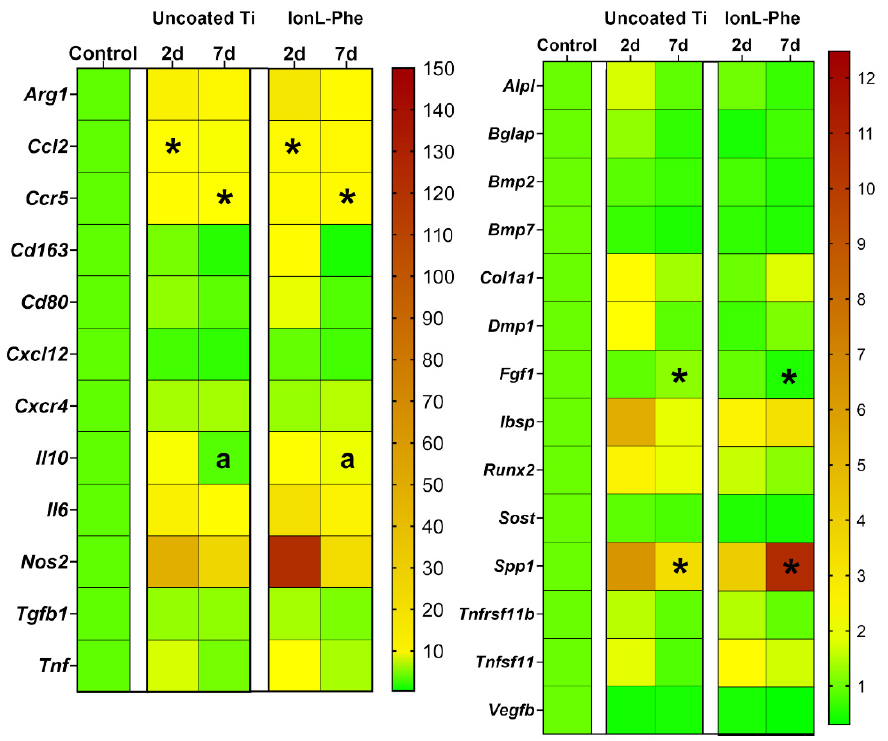
Figure 6. Heat map displaying the fold change of inflammatory, tissue reconstruction, and bone remodeling markers in peri-implant tissue around IonL-coated and uncoated titanium implants over time relative to nonsurgical control ( n = 5). * indicates statistical significance among groups within that time point (* p < 0.05). a indicates p = 0.052 within that time point.